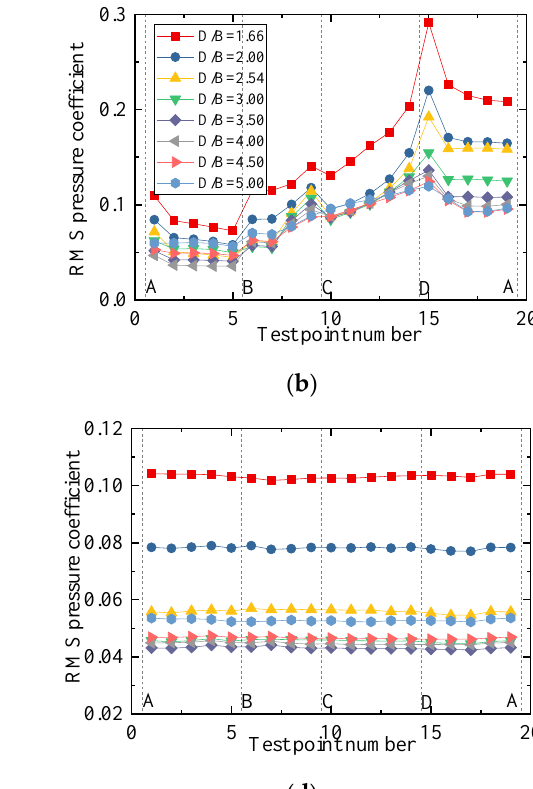
Figure 18. Wind pressure coefficient of the upstream bridge for Case 3: ( a ) Mean values of the outer taps; ( b ) RMS values of the outer taps; ( c ) Mean values of the inner taps; ( d ) RMS values of the inner taps. The three-component coefficients of the downstream bridge are plotted in Figure 19.